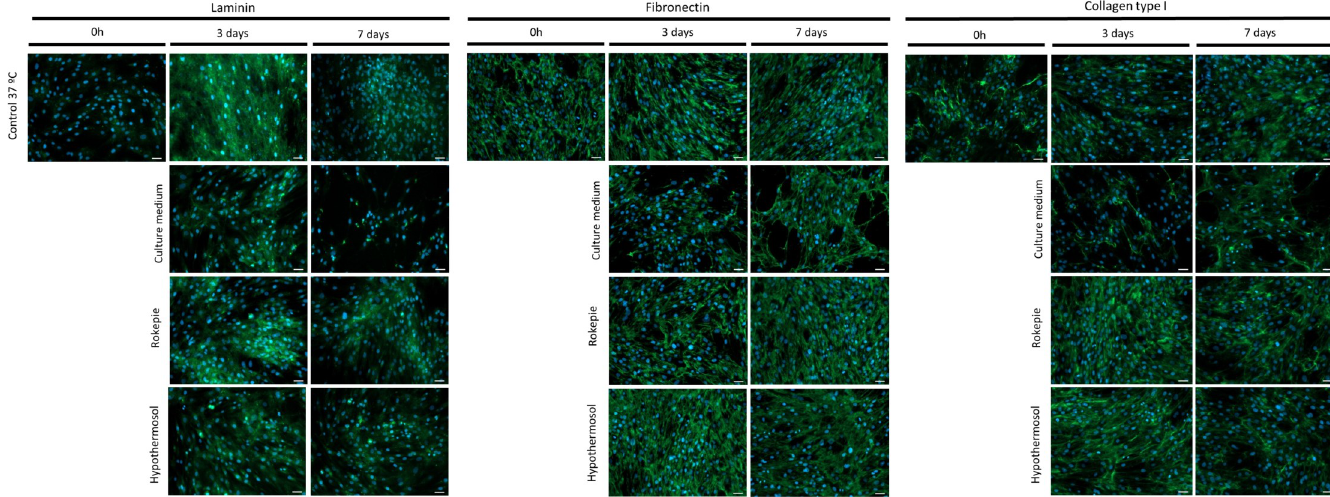
Fig 4. Immunocytochemistry images of expression of extracellular matrix proteins. Representative immunocytochemistry images of expression of extracellular matrix laminin, fibronectin and type I collagen (all in green) in confluent hASCs preserved at 4˚C, in the presence and absence (Culture medium) of hypothermic storage solutions for 3 and 7 days. A control culture at 37˚C was also included. Immunocytochemistry was performed after cultures were subjected to a respective recovery period of 24 hours. Values for 0 hours correspond to cells before 4˚C incubation. Cell nuclei were counterstained with DAPI (blue). Scale bar: 50 μ m.